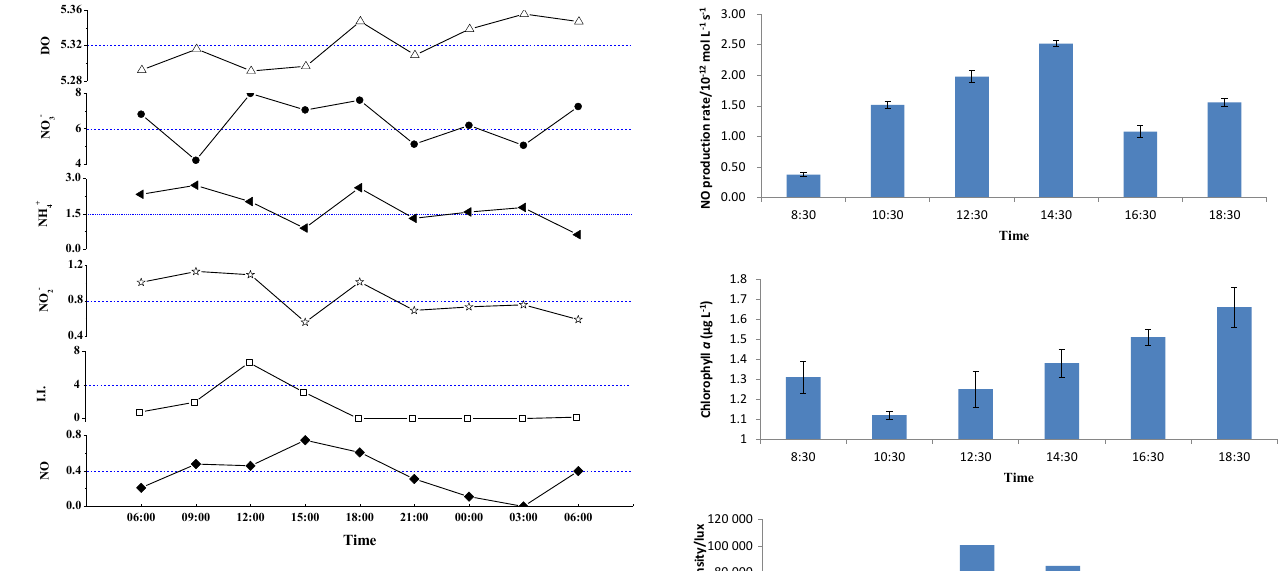
Figure 6. The diurnal variations in NO concentrations and related parameters in the surface seawater at station 10.